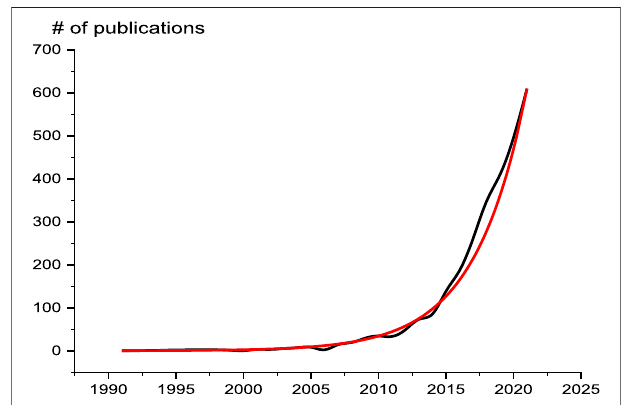
FIGURE 3 | Dynamics of annual publications related to household food waste and the approximation of this process by an exponential function (1993 –